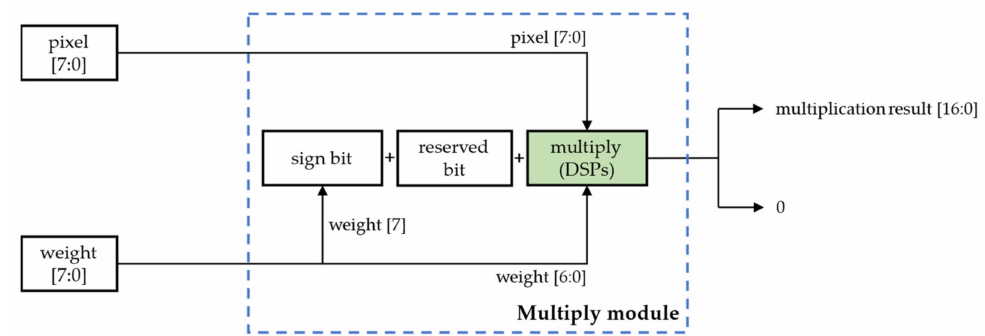
Figure 5. The multiplicative-based computation processing element.